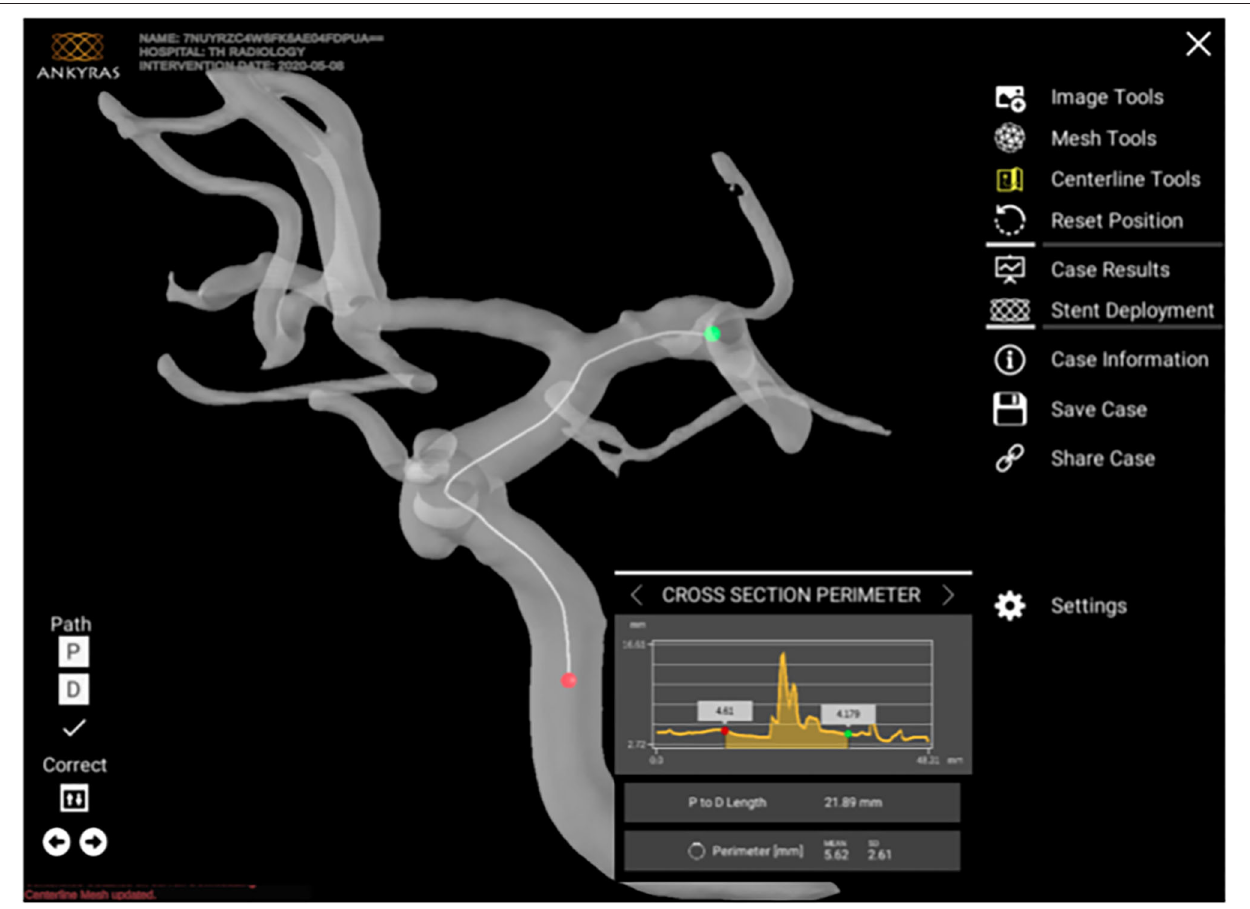
FIGURE 2 | Flow diverter braiding structure, being L the length of the stent at the nominal position and φ the nominal diameter of the stent. Right: detailed definition of a unit pore cell, translations and reflections of the unit cell along the surface of the stent covers its whole surface. Being S the constant length of the strut, ω the width of the strut, α the angle with the longitudinal direction of the stent, and S y and S y the projections of the wire at the crossing point. A and B are the non-occupied areas of the unit